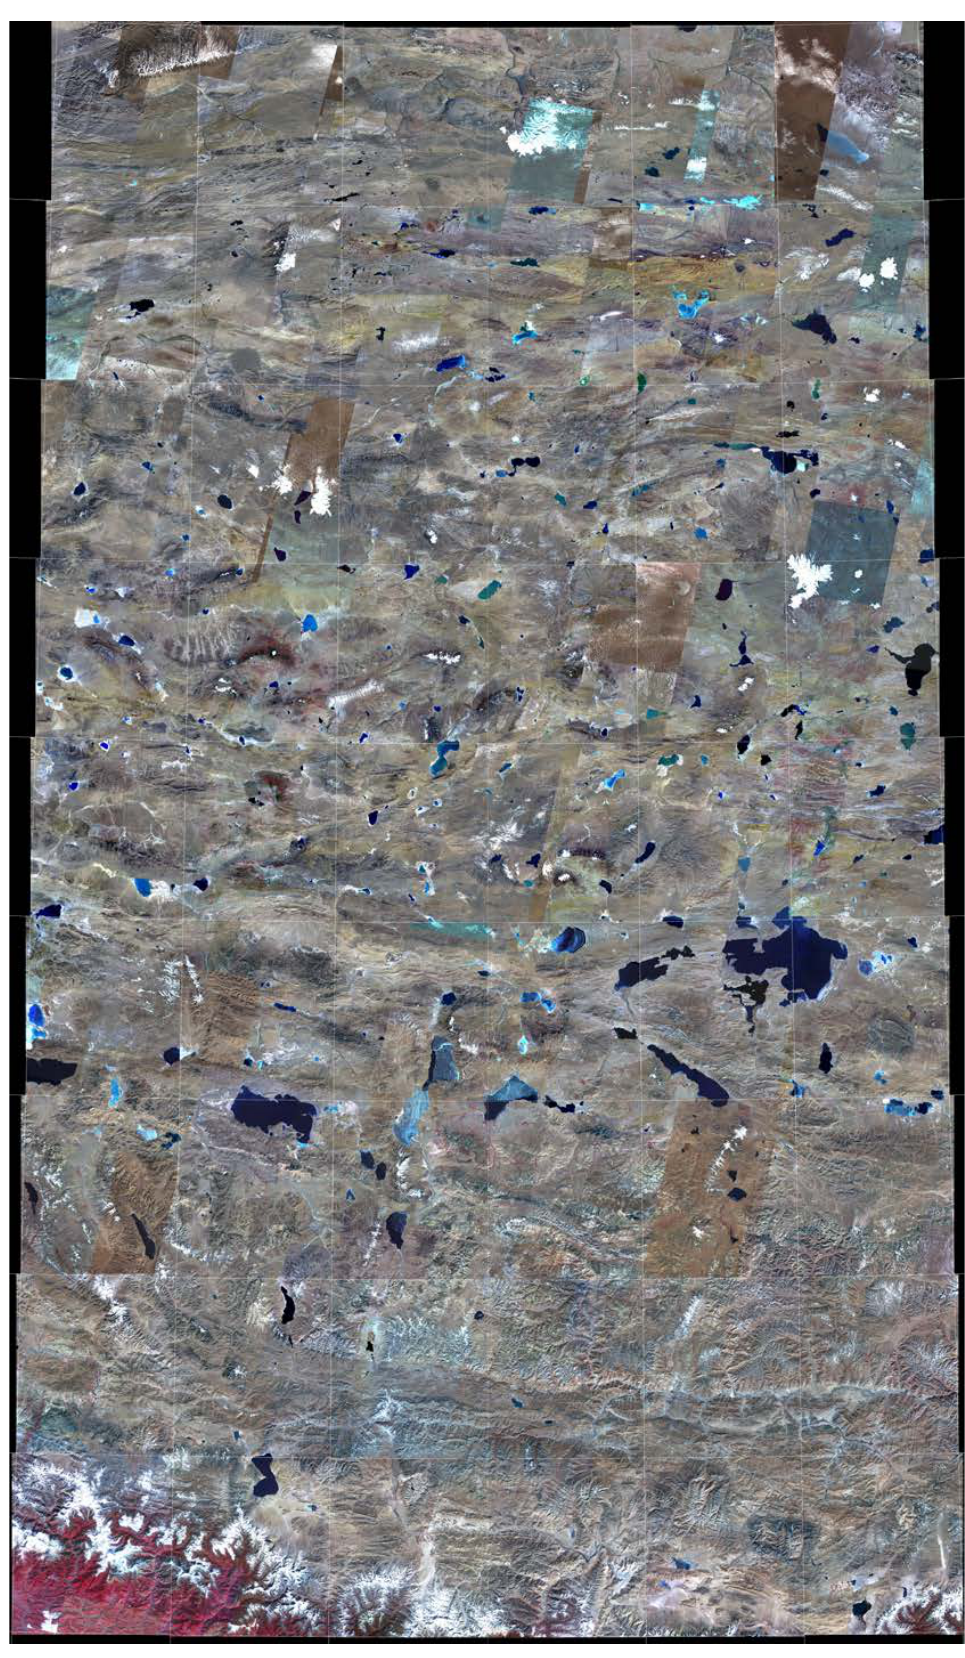
Figure A1. High resolution version of Figure 2 without annotated information.